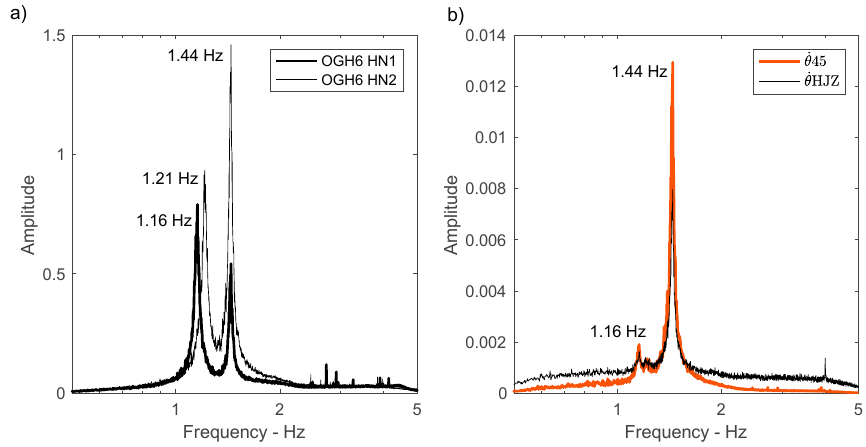
Figure 5. Averaged Fourier spectra of the 10 min windows. ( a ) acceleration in translation at station OGH6; ( b ) rotation rate obtained by rotation sensor HJZ and derived from the array using OGH4 and OGH5 stations (Equation (1)).